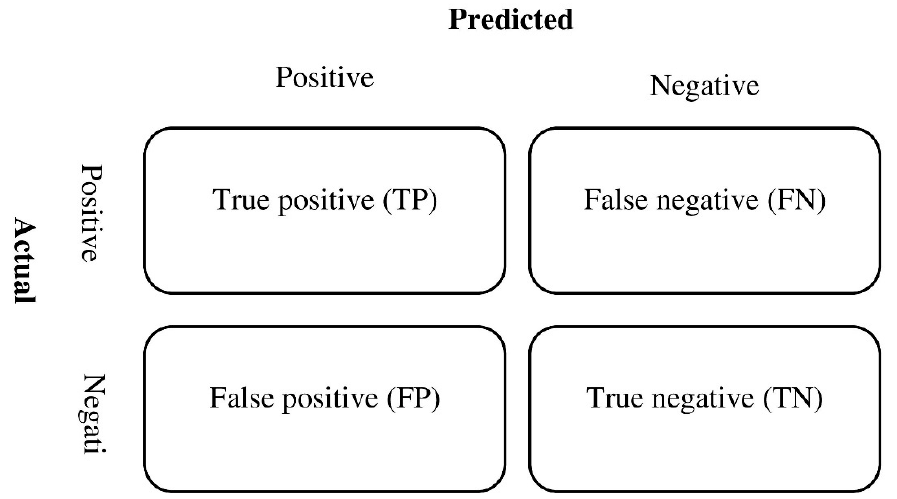
Figure 4. Contingency table for binary decisions.